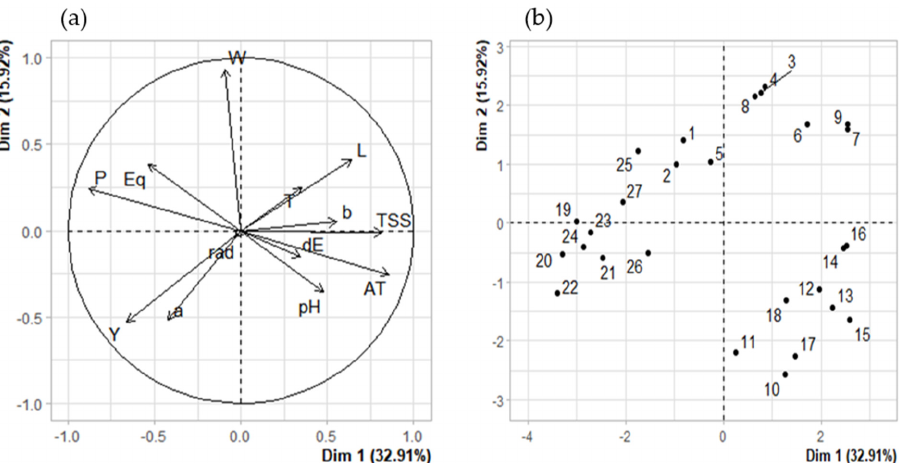
Figure 3. Principal component analysis (PCA) of physical and chemical variables of calafate berry extracts. P, polar diameter; Eq, equatorial diameter; W, weight; L, *a, *b CIE L*a*b* components; dE, Δ E; TSS, total soluble solids; AT, Sum of individual anthocyanins; T, temperature; rad, maximum radiation per day. ( a ) PCA of variables. ( b ) PCA of individuals. Solar radiation exposure had no influence on parameters such as size (P, Eq) and weight (W) (Figure 2), but it was slightly negative correlated with color parameters ( *L ,